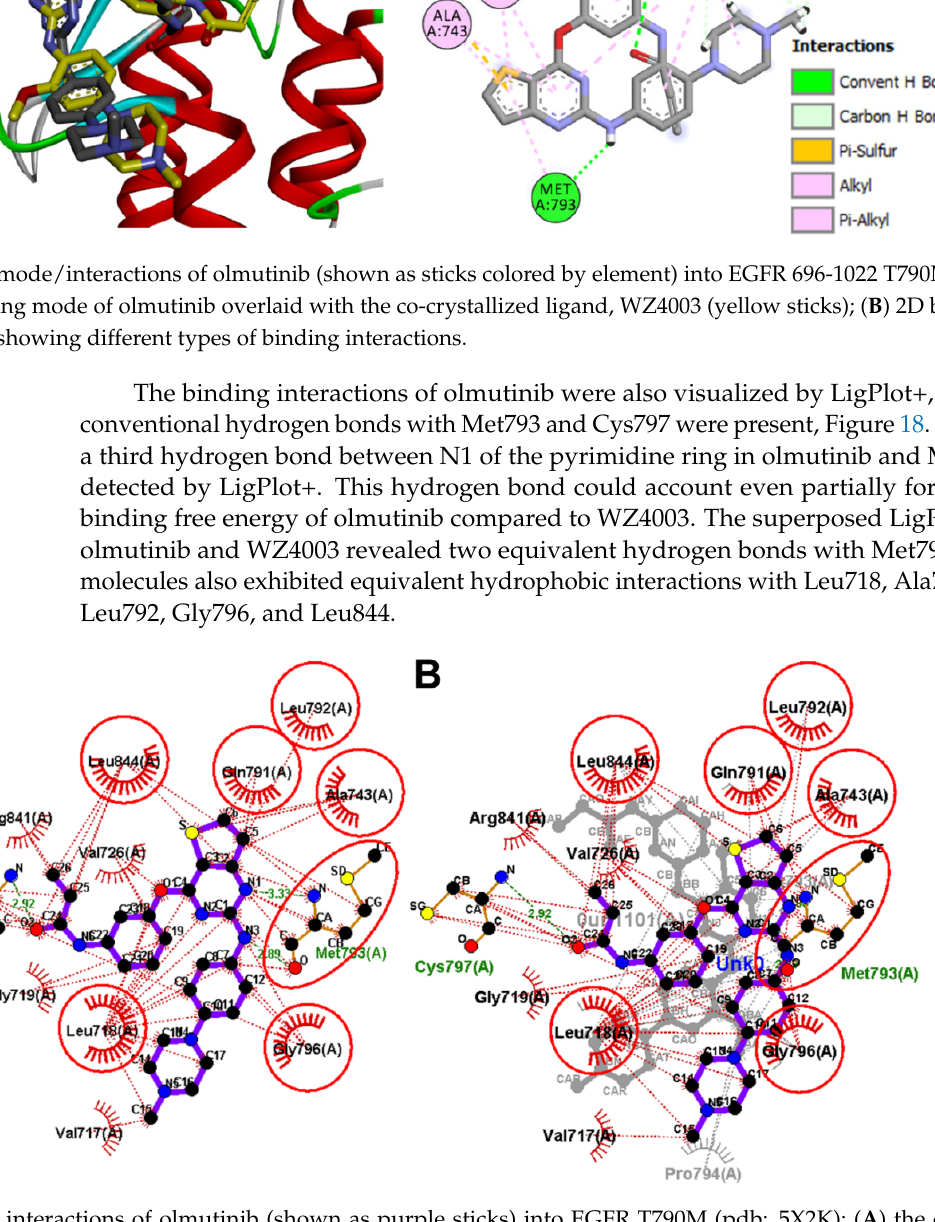
Figure 16. Binding interactions of the redocked WZ4003 (shown as purple sticks) into EGFR T790M (pdb: 5X2K): ( A ) redocked WZ4003; ( B ) superposed LigPlot view of the redocked WZ4003 (purple sticks) overlaid with the co-crystallized ligand (gray sticks), the red circles/ellipses show the equivalent binding interactions of the two molecules, hydrogen bond is shown in olive green dotted lines (Met793), and hydrophobic interactions are shown in brick red dotted lines.